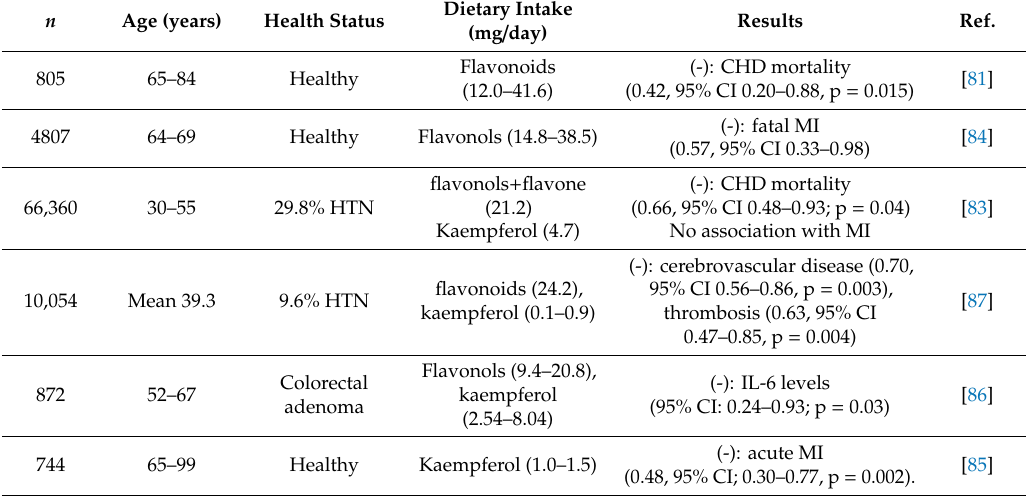
Table 6. Epidemiological studies on the association between flavonoids intake and cardiovascular